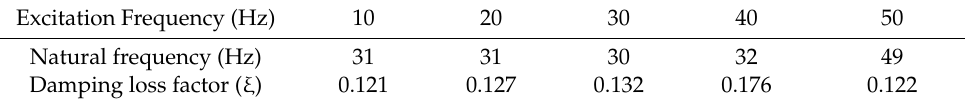
Table 4. Damping loss factor and natural frequency of the confined granular